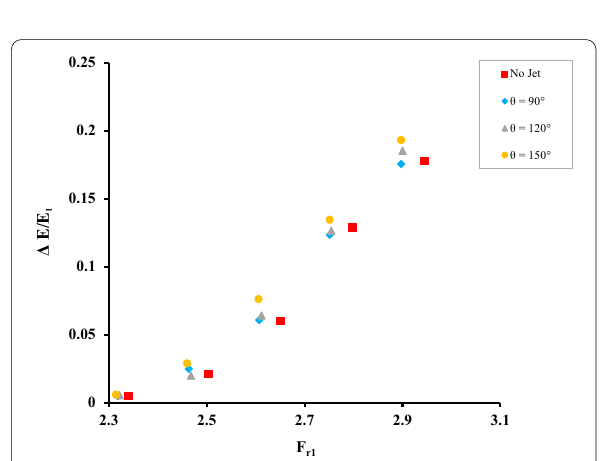
Fig. 2 Relative energy dissipation Δ E/E 1 versus F r 1 for the tested flow jet arrangements at gate opening G